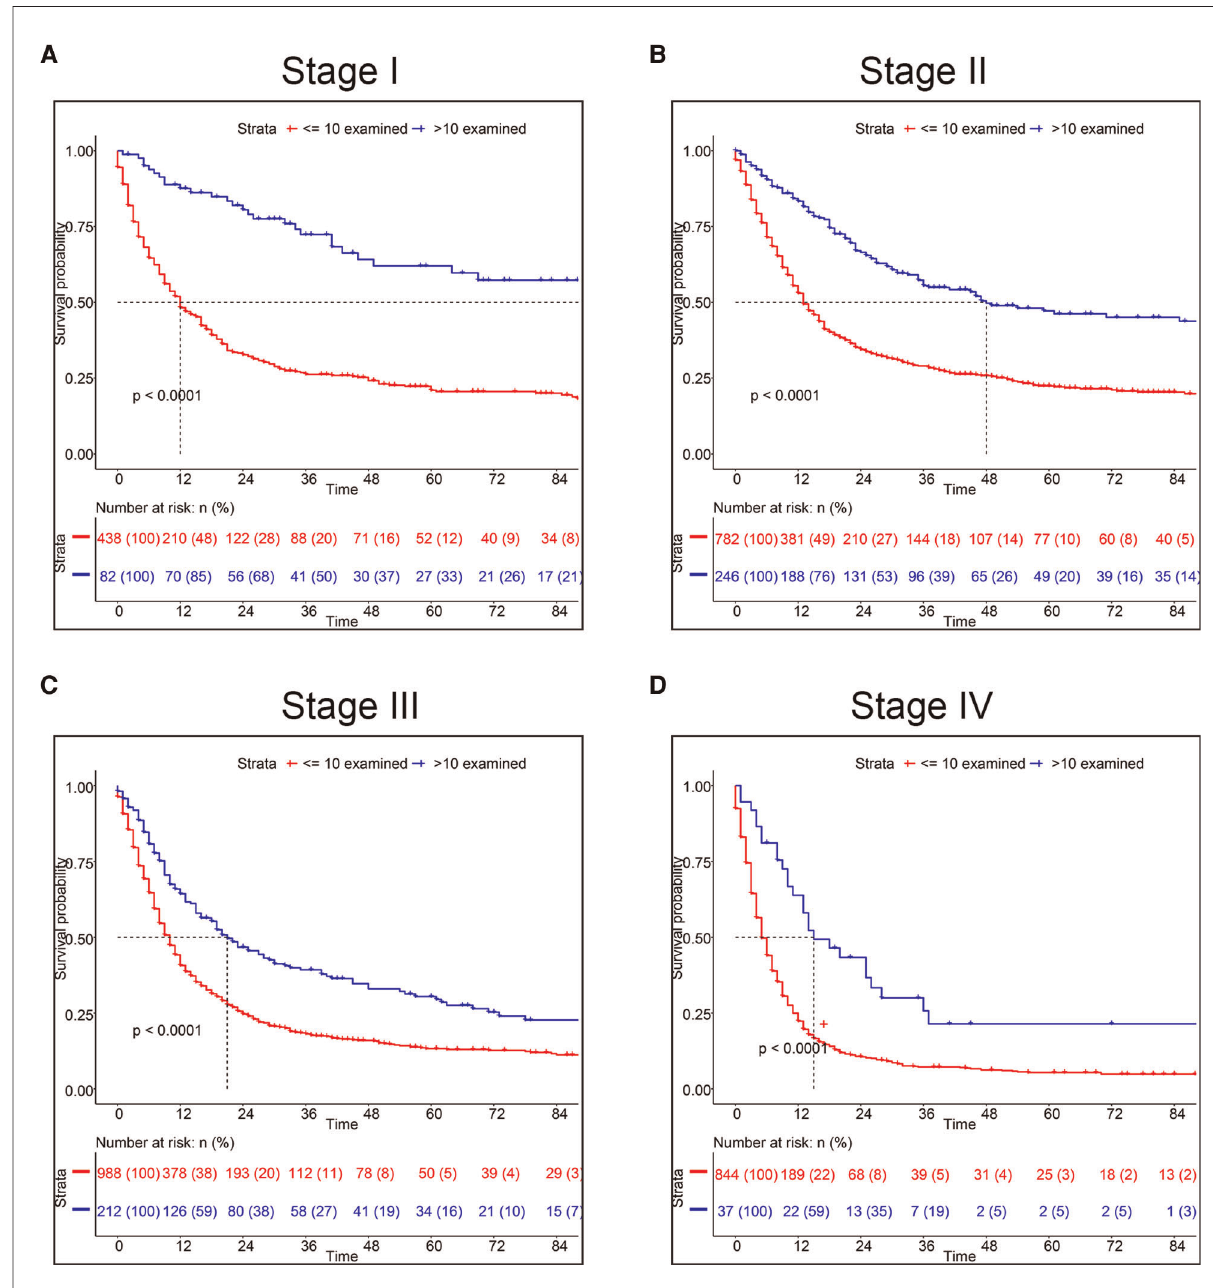
FIGURE 2 Kaplan-Meier survival analysis for CSS based on the number of ELNs. ( A ) Stage I, ( B ) Stage II, ( C ) Stage III, ( D ) Stage